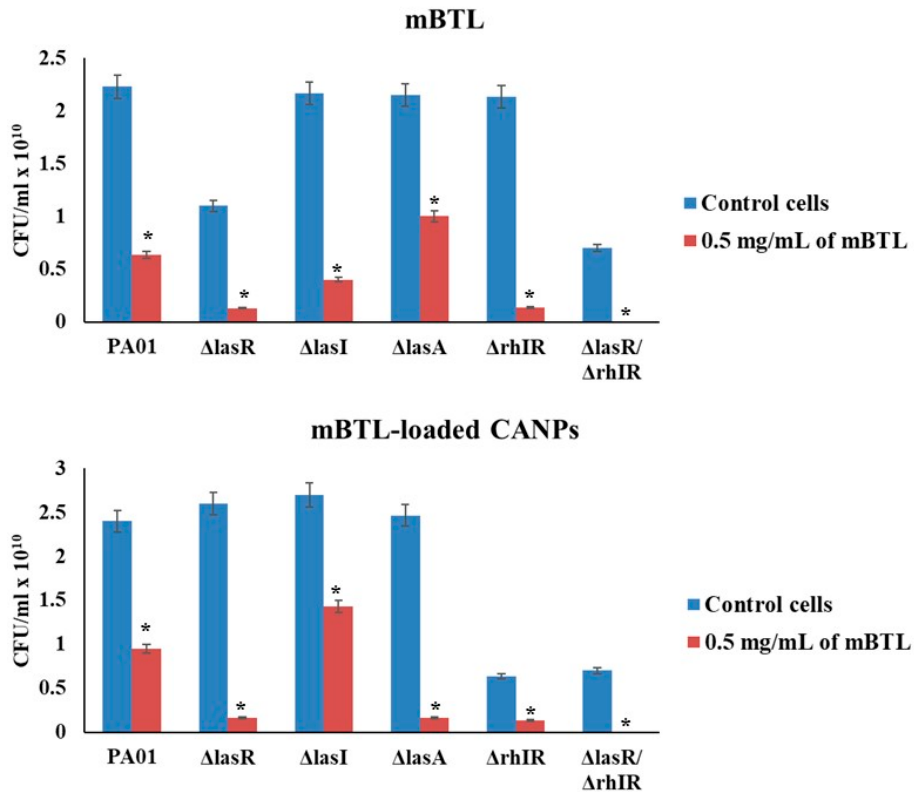
Figure 7. Effects of mBTL-loaded CANPs on the adhesion of P. aeruginosa isolates to A549 cells. Quantitative analysis of bacterial adhesion to A549 cells. Blue histogram: A549 cells infected with PA01, ( Δ lasR ), ( Δ lasI), ( Δ IasA), ( Δ rhIR), and ( Δ lasR / Δ rhIR ) as control cells. Red histogram: A549 cells infected with wild-type and QS mutant strains and simultaneously treated with 0.5 mg/mL of mBTL or mBTL-loaded CANPs. The data are presented as the mean ± SD of triplicate experiments. * Based on ANOVA, p < 0.05 relative to control cells.